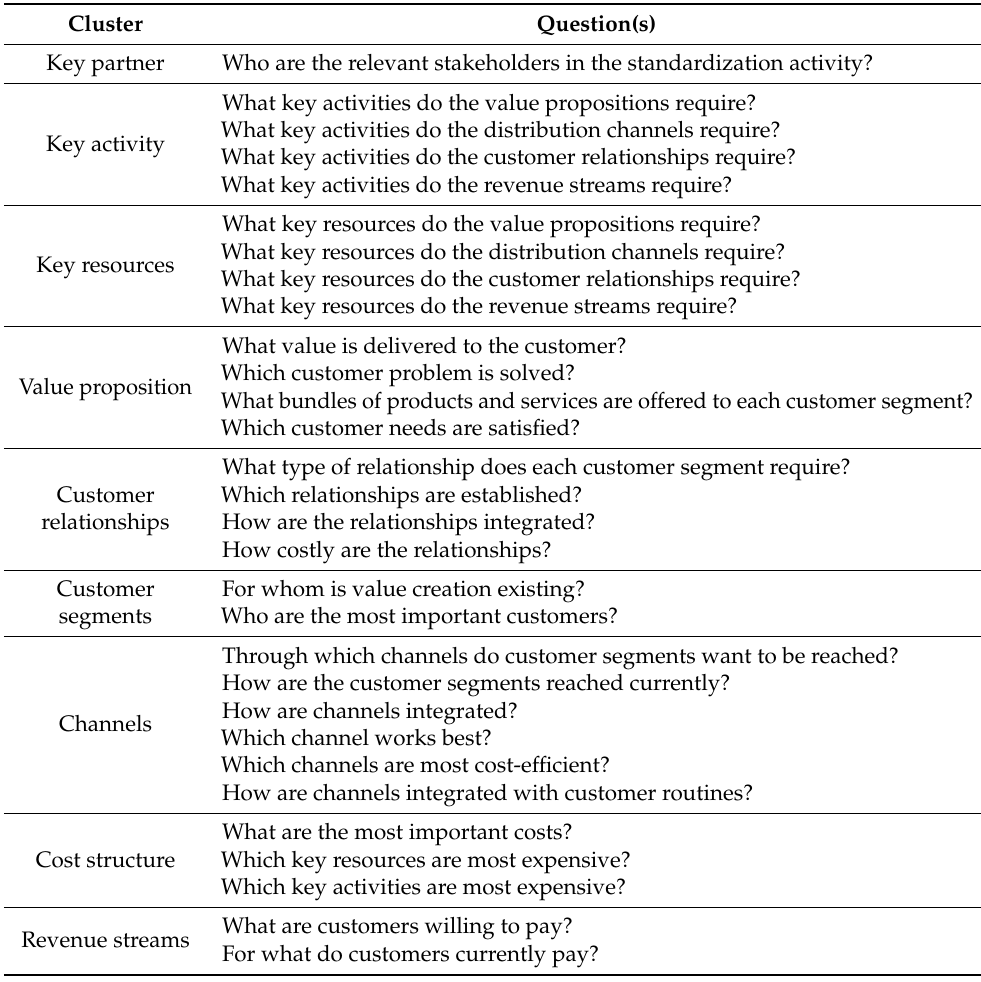
Table 1. Thematic clusters and corresponding questions used for the identification of key success factors for corporate standardization